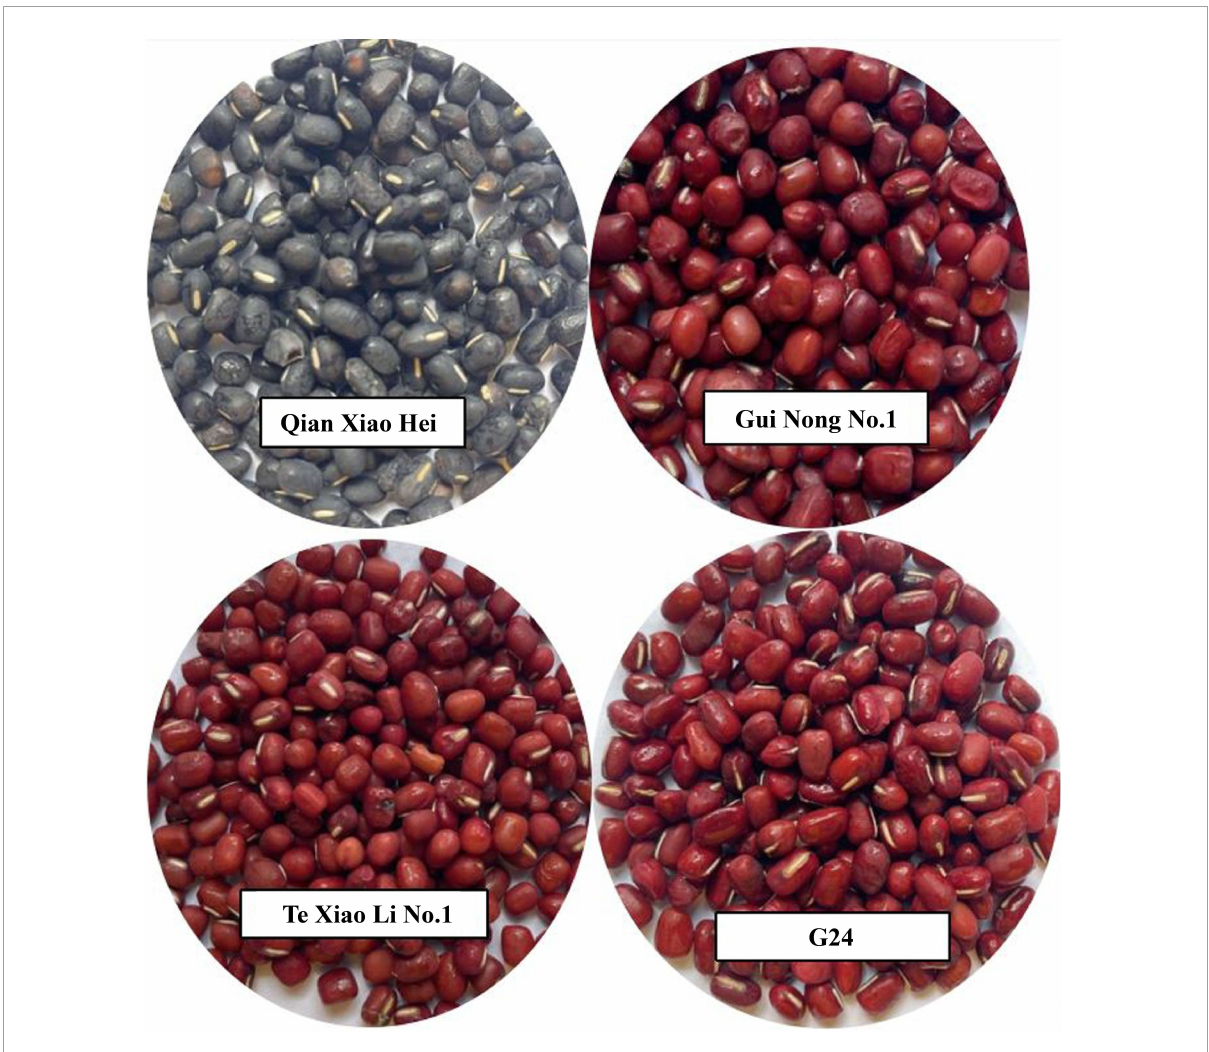
FIGURE1 Four varieties of adzuki beans (G24, Te Xiao Li No. 1, Gui Nong No. 1 and Qian Xiao Hei).